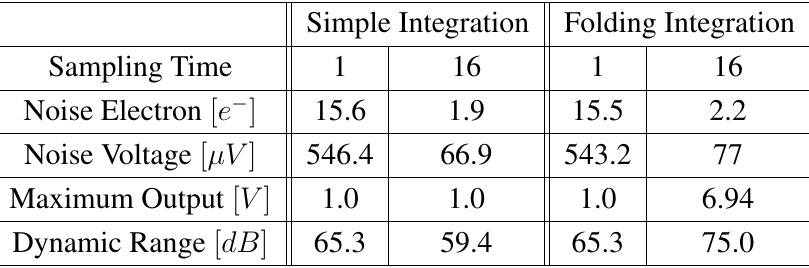
Table 2. Noise and dynamic range of the SI- and